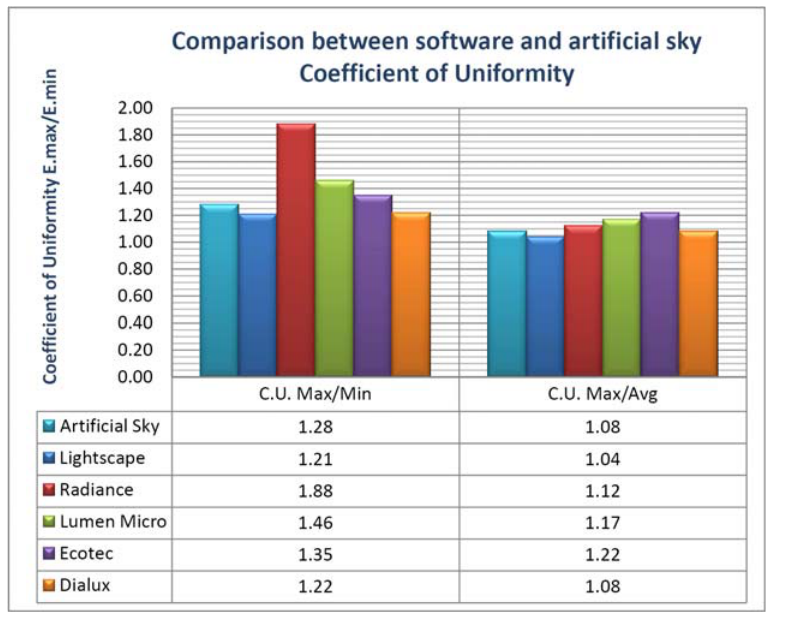
Figure 12. Comparison of the Uniformity Coefficients between software and artificial